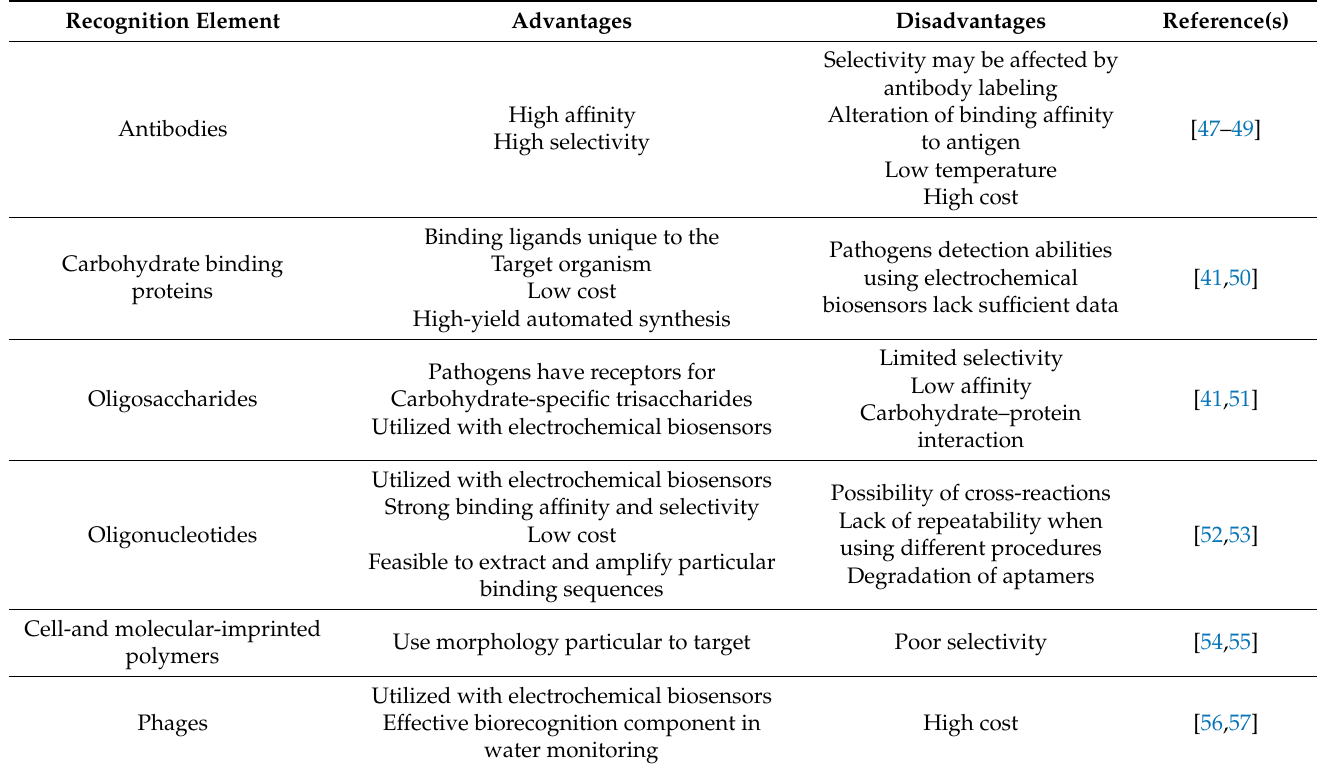
Table 1. Pathogen-based biorecognition elements.